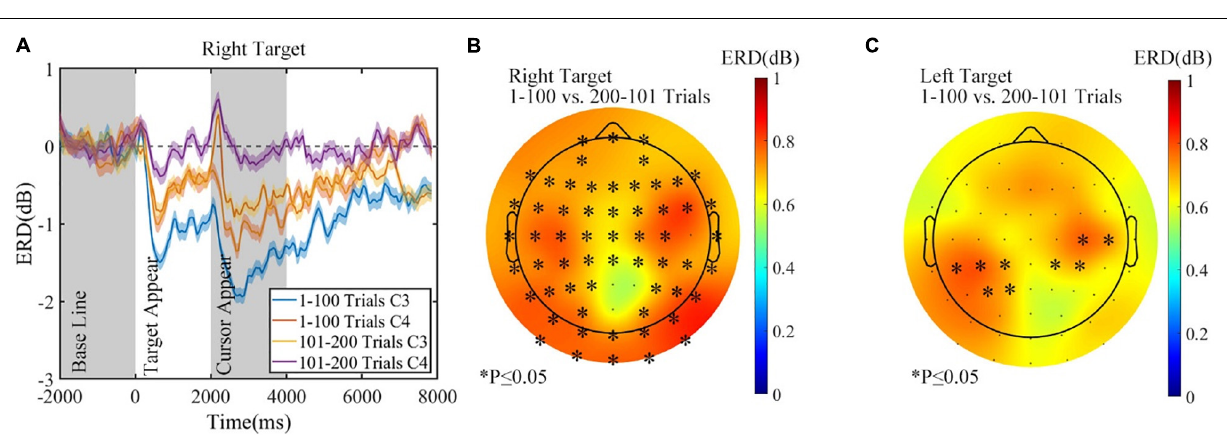
FIGURE 10 | The alpha (8–13 Hz) ERD changes before rest period in all sessions. (A) The ERD of C3 and C4 in the first 200 trials, right target. (B) The ERD change before rest, right target. (C) The ERD change before rest, left target. ∗ p ≤ 0.05. ERD, event-related